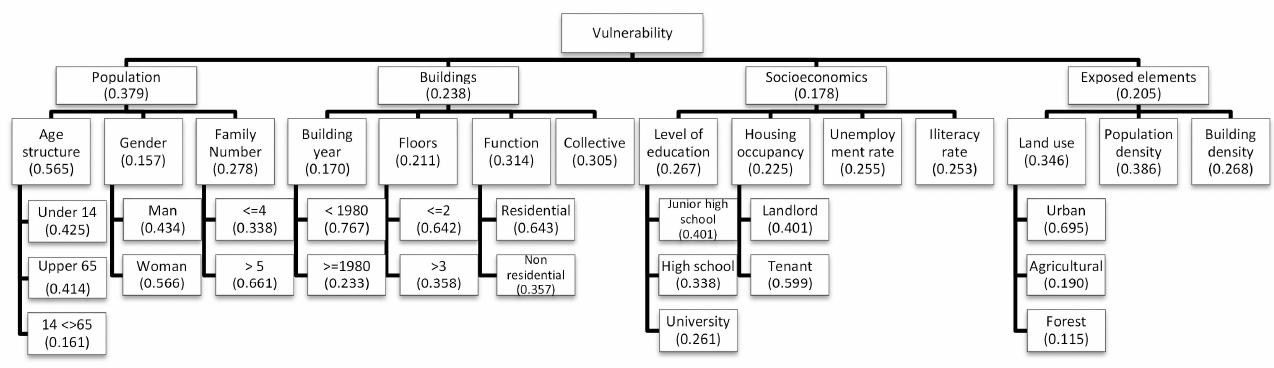
Figure 6. Final criteria and sub-criteria AHP-GDM weights.